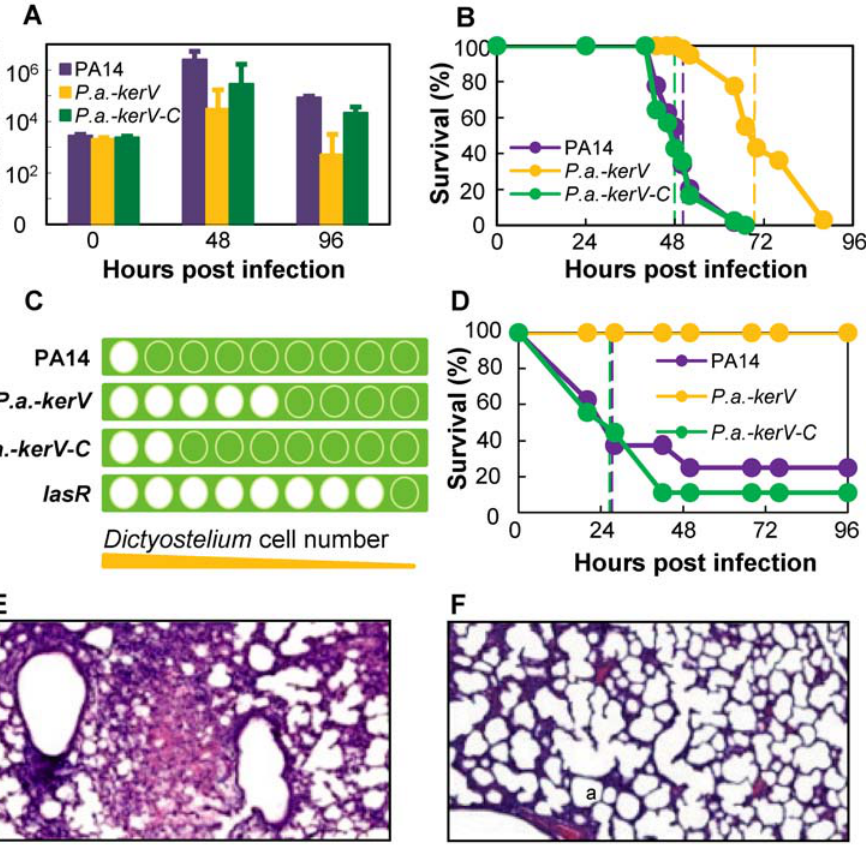
Figure 1. KerV acts as a virulence determinant in P.aeruginosa against a range of eukaryotic hosts. (A) Bacteria quantities recovered from infected plant leaves. (B) Fly survival kinetics in a pricking infection model. Dotted lines are color-coded and represent survival medians for corresponding strains. (C) Amoeba phagocytosis of P. aeruginosa . The graphic was produced from representative experimental observations. For detailed data see Table S1. Green square, bacterial lawn; green-filled circle, no phagocytosis of bacteria; white-filled circle, clear zone due to phagocytosis of bacteria. From left to right the numbers of laid Dictyostelium were 2.0 6 10 5 , 8.0 6 10 4 , 3.2 6 10 4 , 1.3 6 10 4 , 5.1 6 10 3 , 2.0 6 10 3 , 8.2 6 10 2 , 3.3 6 10 2 and 1.3 6 10 2 . (D) Mouse survival kinetics in an acute lung infection model. (E and F) Histology of the infected neonatal mice lungs by PA14 (E) and P.a.-kerV (F) in the acute lung infection model. a-alveoli.